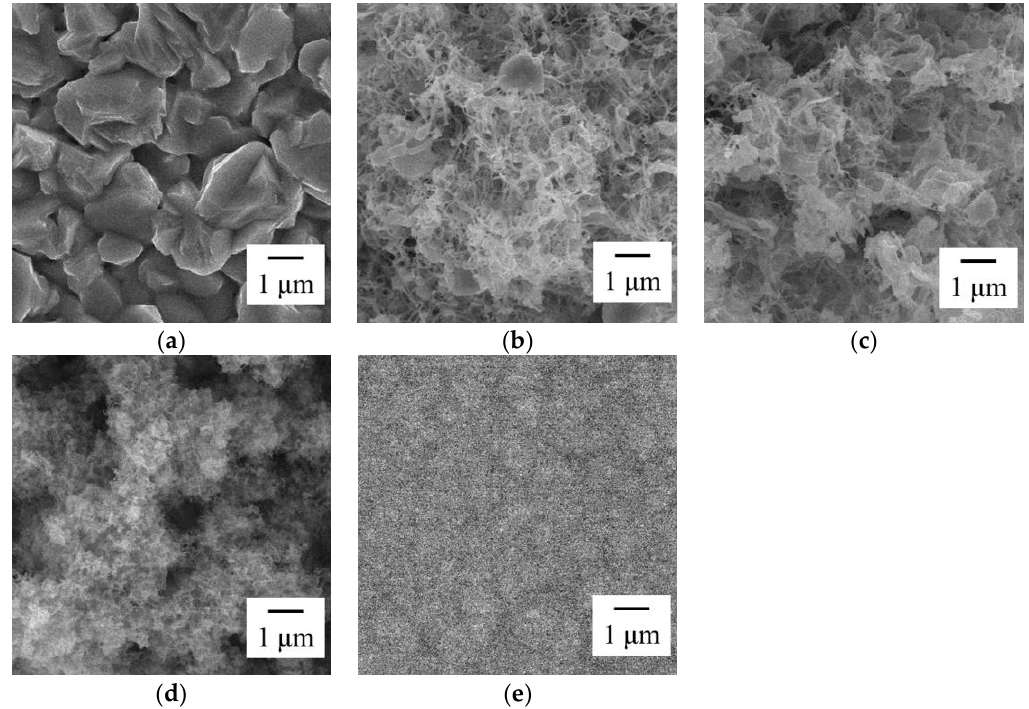
Figure 1. SEM images of the Zn–Fe–Mo platings deposited at various pH values. ( a ) pH 4.0; ( b ) pH 4.5; ( c ) pH 5.0; ( d ) pH 5.5; and ( e ) pH 5.7.